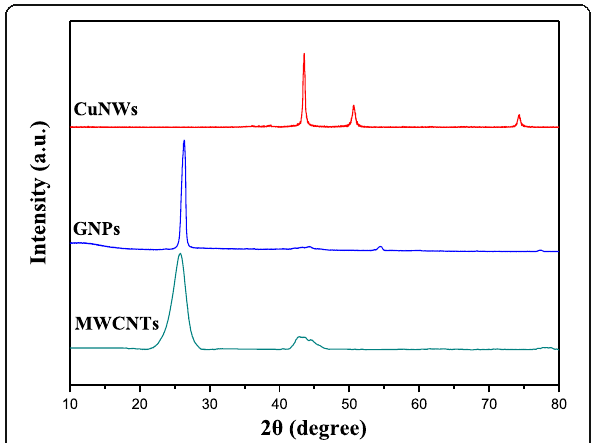
Fig. 2 XRD patterns of CuNWs, GNPs, and MWCNTs